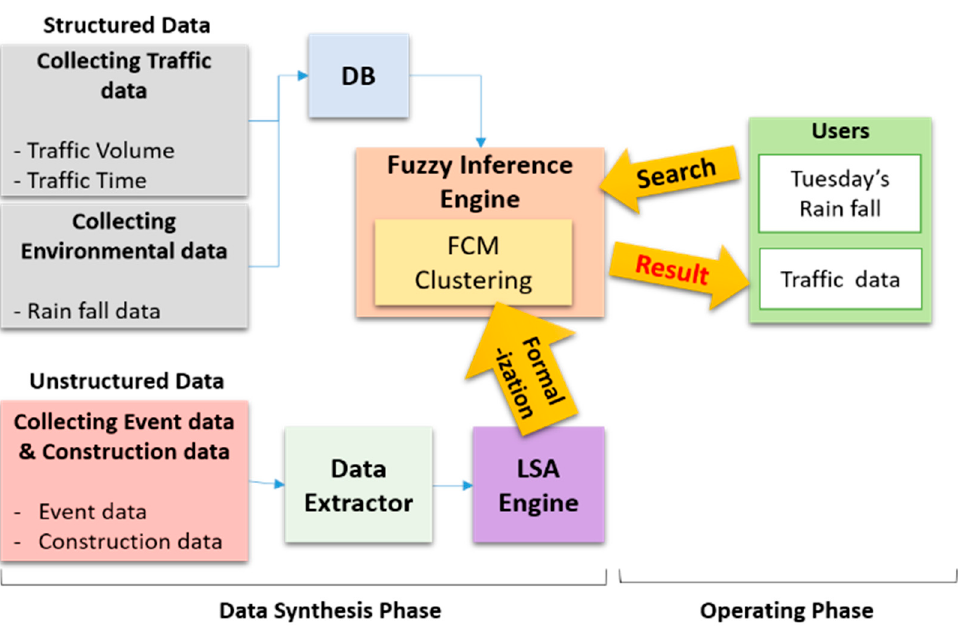
Figure 3. Proposed system architecture.